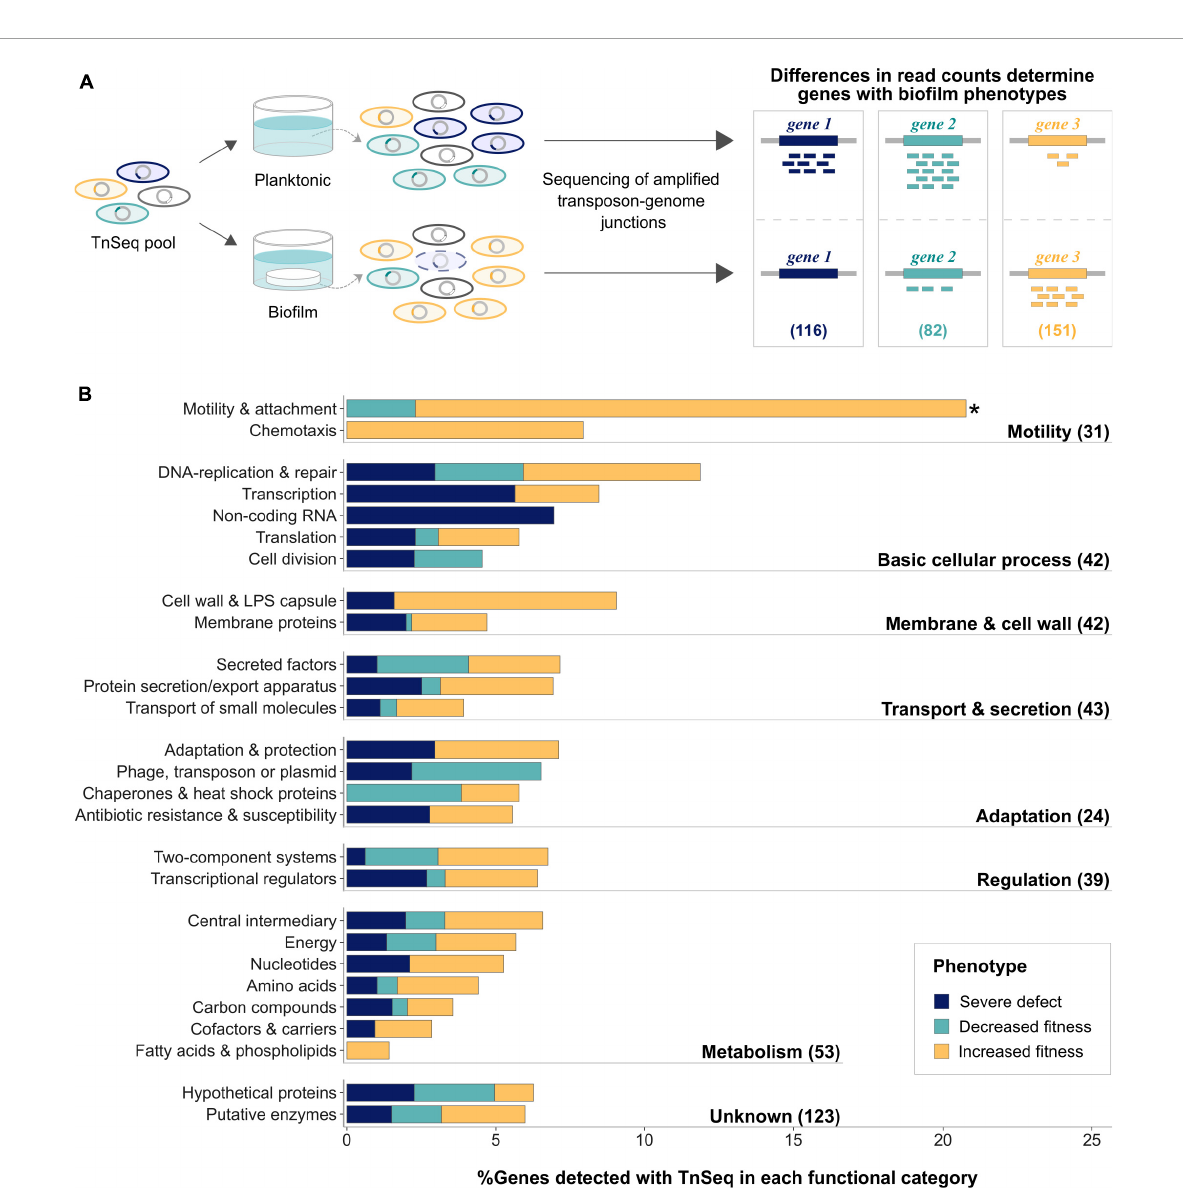
FIGURE1 Biofilm genes identified using TnSeq were enriched for motility and attachment genes. (A) Transposon mutants present in biofilms and planktonic cultures were compared by amplifying and sequencing transposon genome junctions. Differences in read counts between the two conditions determined biofilm genes with (1) severe defects (blue; reads in planktonic samples, but no reads in biofilm), (2) decreased (aqua; significantly less reads in biofilm) and (3) increased fitness phenotypes (light orange; significantly more reads in biofilm). Numbers of genes causing each biofilm fitness phenotype when mutated are indicated in brackets. (B) Functional enrichment of the identified genes using PseudoCAP categories, which are summarized into major functional groups as indicated in bold on the right. Number of identified genes belonging to each group are indicated in brackets. Colors indicate the proportion of genes with different phenotypes. The significantly enriched functional category is highlighted with an